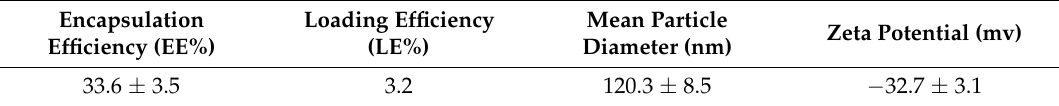
Table 1. The encapsulation efficiency, loading efficiency and average size of the nanoparticles encapsulating simvastatin (SIM) (SIM-PP